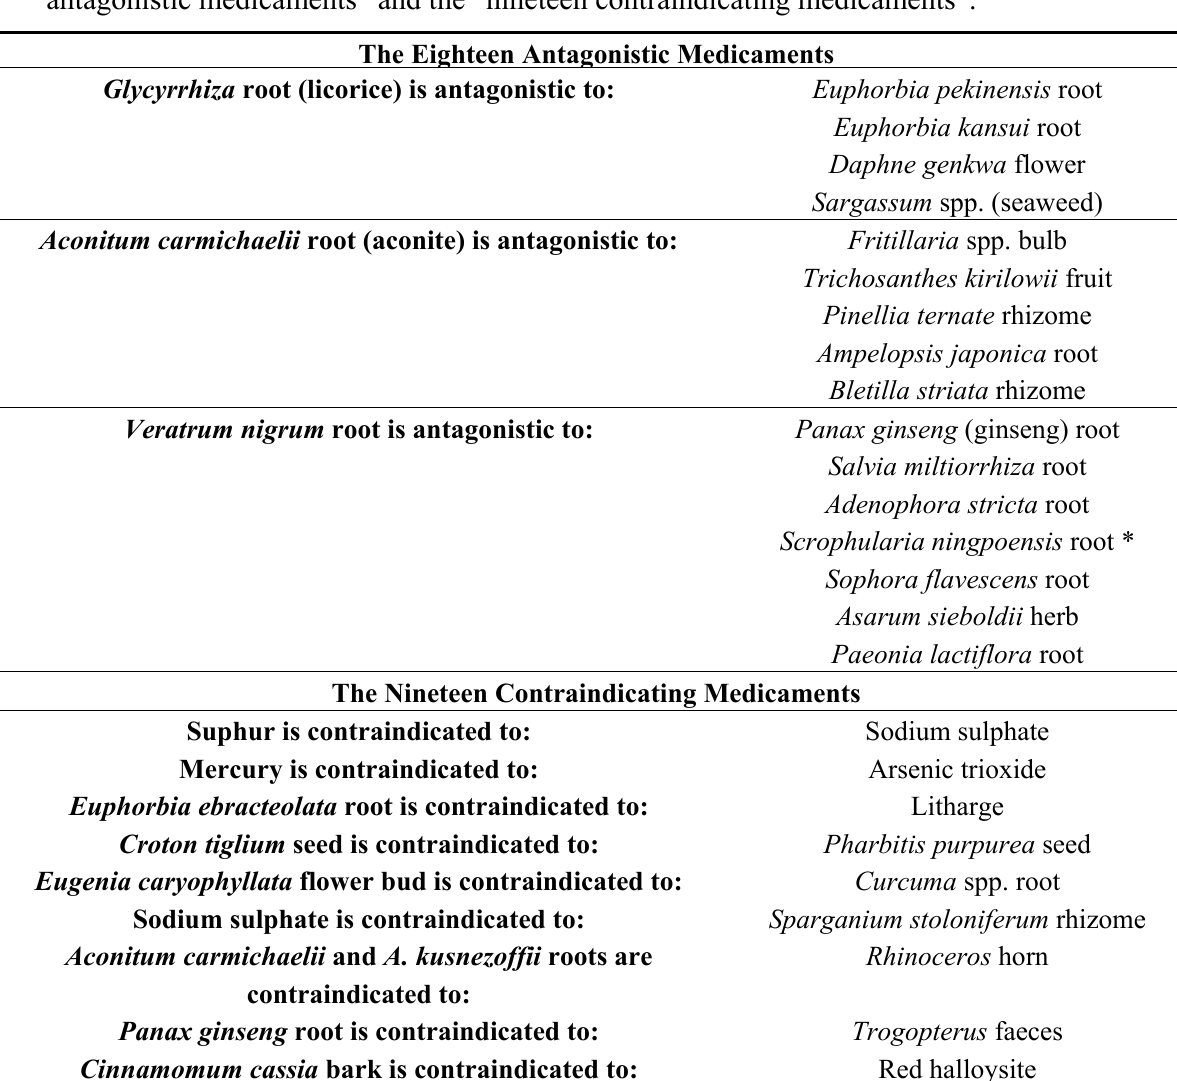
Table 1. Chinese traditional knowledge of incompatible herbal drug pairs:the “eighteen antagonistic medicaments” and the “nineteen contraindicating